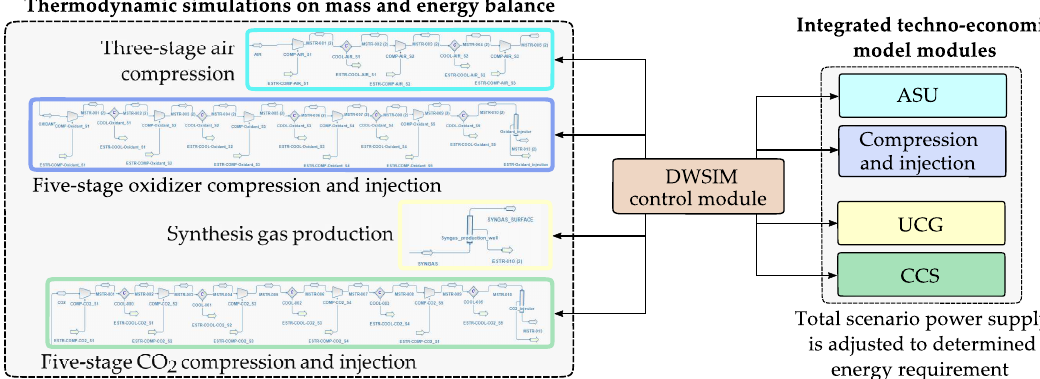
Figure 5. Integration of the techno-economic model with thermodynamic process simulations by means of the DWSIM process simulator [22], considering air compression, oxidizer compression and injection, synthesis gas production, as well as CO 2 compression and